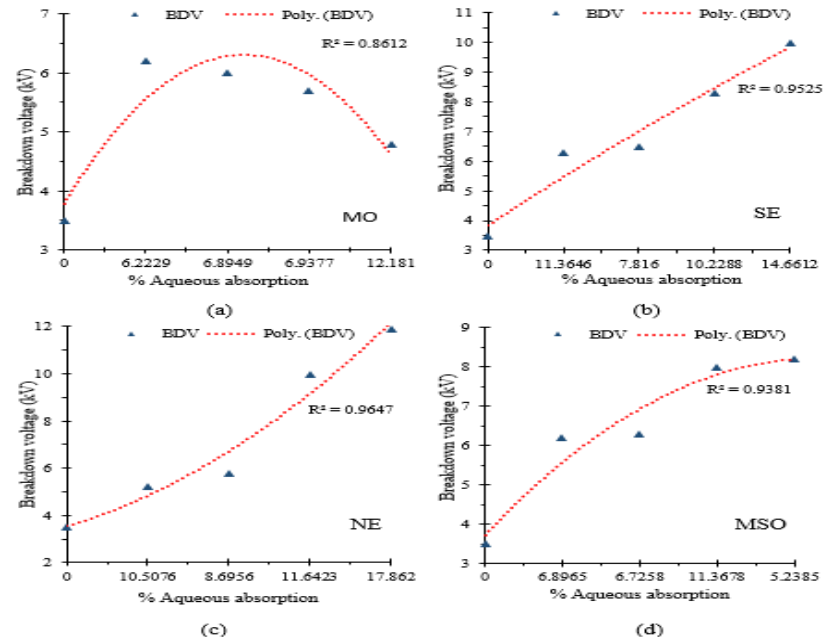
Figure 14. Regression plots for 0.2 mm thickness paper in various insulating oils. ( a ) Insulating liquid MO, ( b ) Insulating liquid SE, ( c ) Insulating liquid Ne, and ( d ) Insulating liquid MSO.